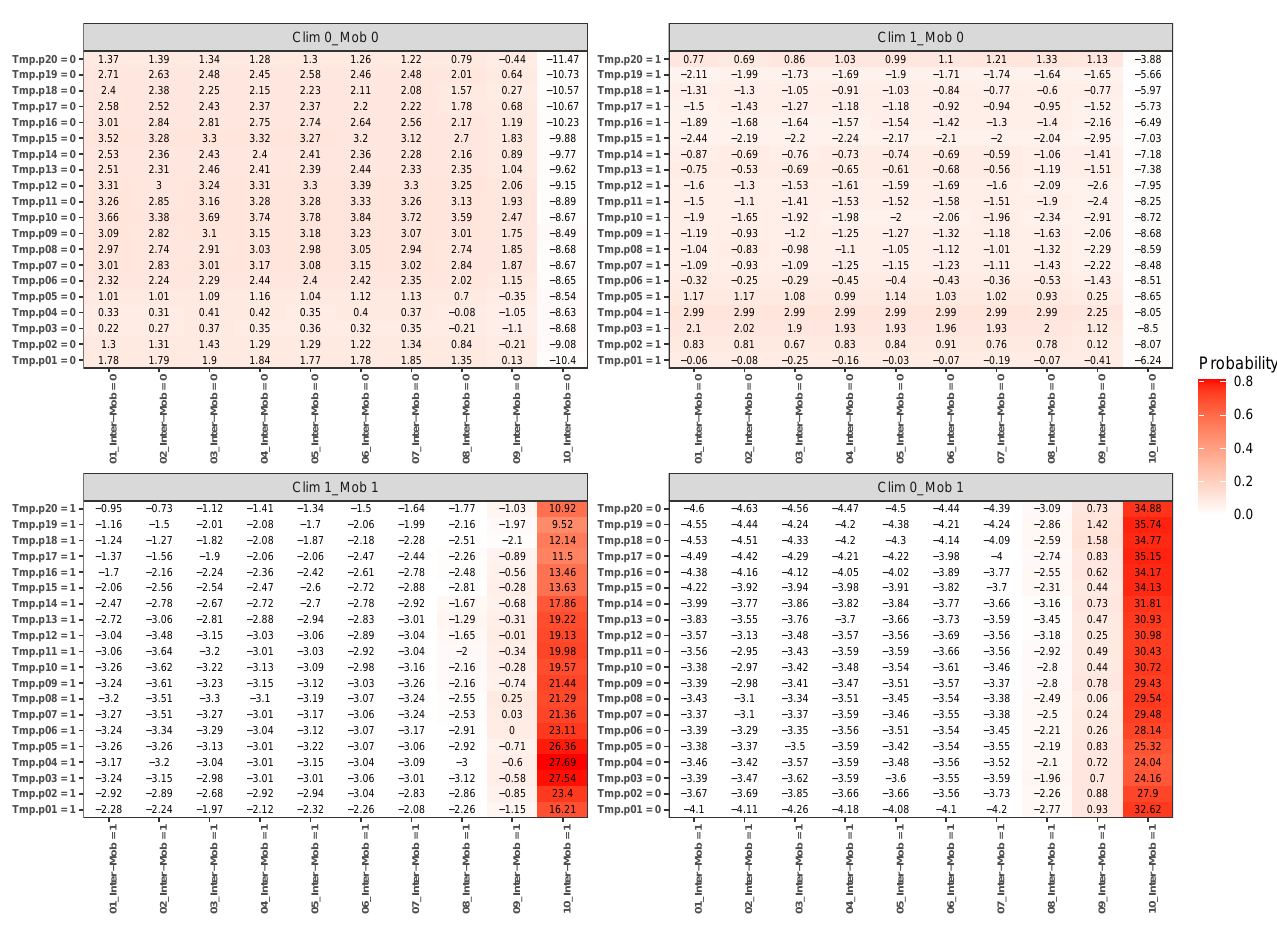
) and P ( C ) for each combination of habitat variable ranges Figure 7. ε ( C X m X n X m X n i j i j | | = Average annual temperature and X n = Internal labour flow of the municipality for the four combina- X m i j = 0, 1 and X m = 0, 1 corresponding to absence/presence for each variable bin, tions X m i i